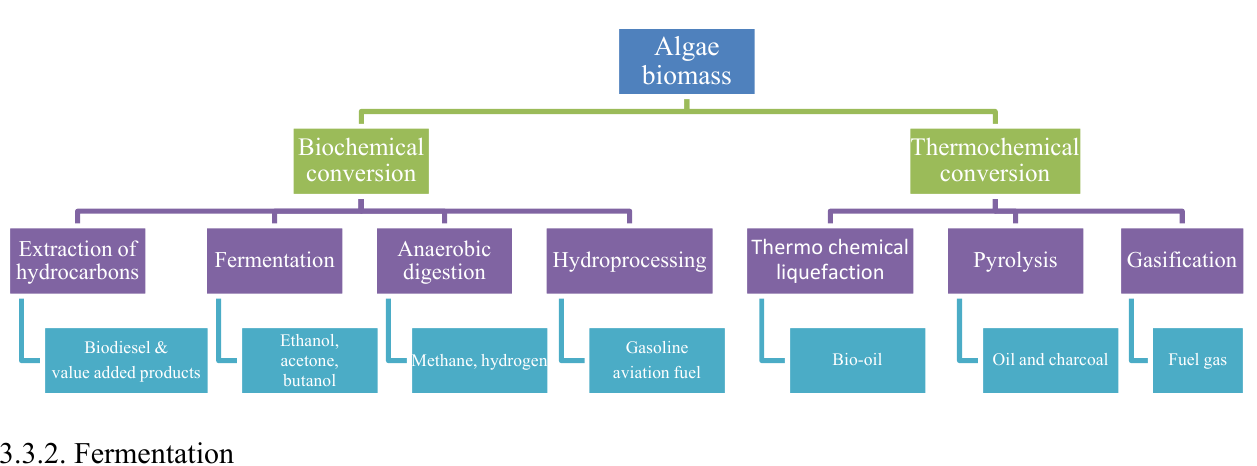
Figure 1. Potential algal biofuel conversion processes, adapted from